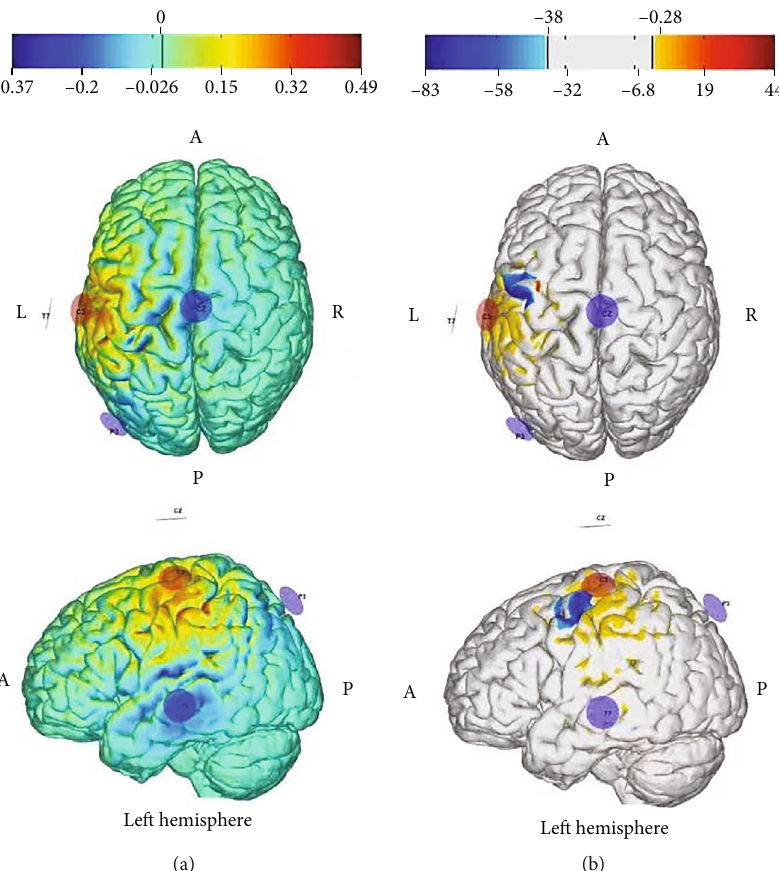
Figure 3: Simulated electrical fi eld. L: left; A: anterior. The total stimulation intensity is 2 mA. The position of anodal electrode is at C3. The positions of cathodal electrodes are at CZ, T7, and P3. (a) is the normal electric fi eld component in target region (v/m) for grey matter. (b) is the error with respect to no intervention (mv 2 /m 2 ) for grey matter.